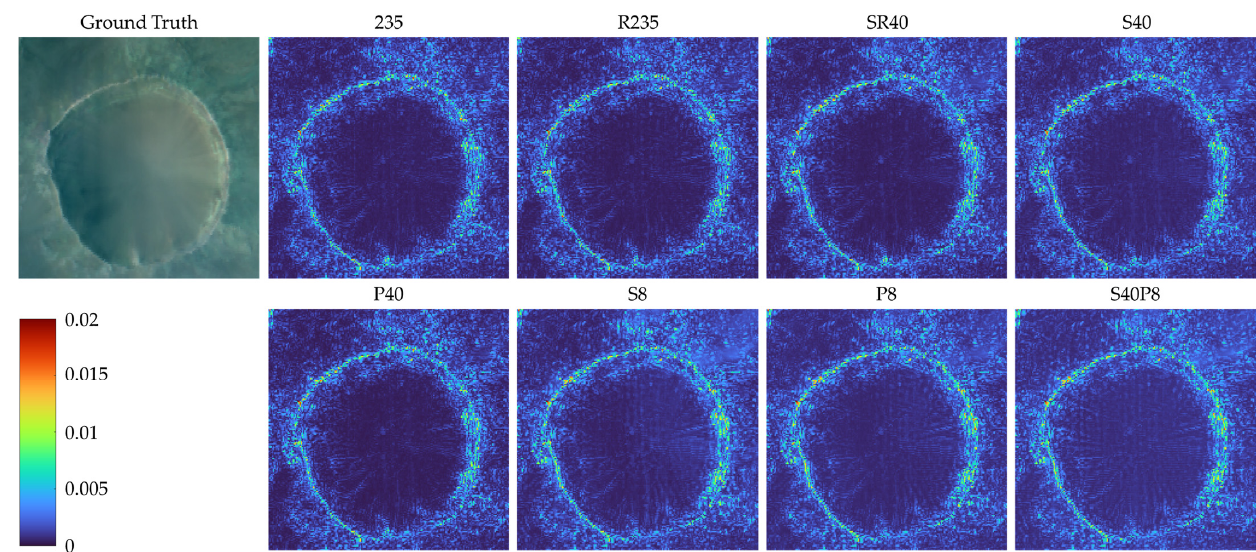
Figure 7. The RMSE of all 235 bands between the ground truth and the SR reconstruction images. The image in the first column are the original high-resolution (ground truth) image. The images in the other four columns are the RMSE of all 235 bands between the ground truth and the SR reconstruction data reconstructed by the models trained on different datasets, and the name of the datasets are labeled in the titles of these images.